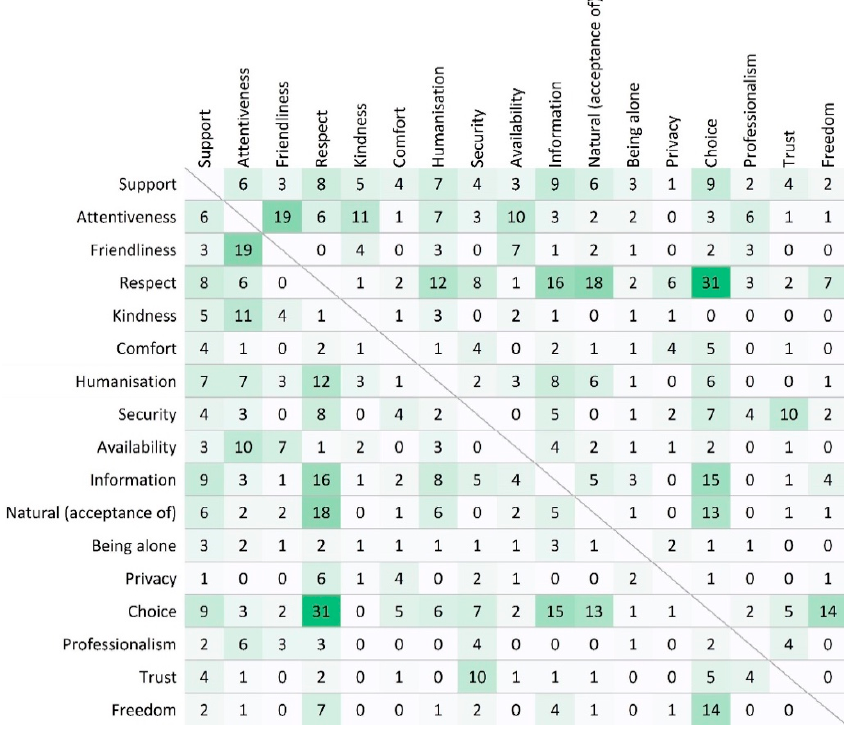
Figure 2. Association of two components of care in the same answer.